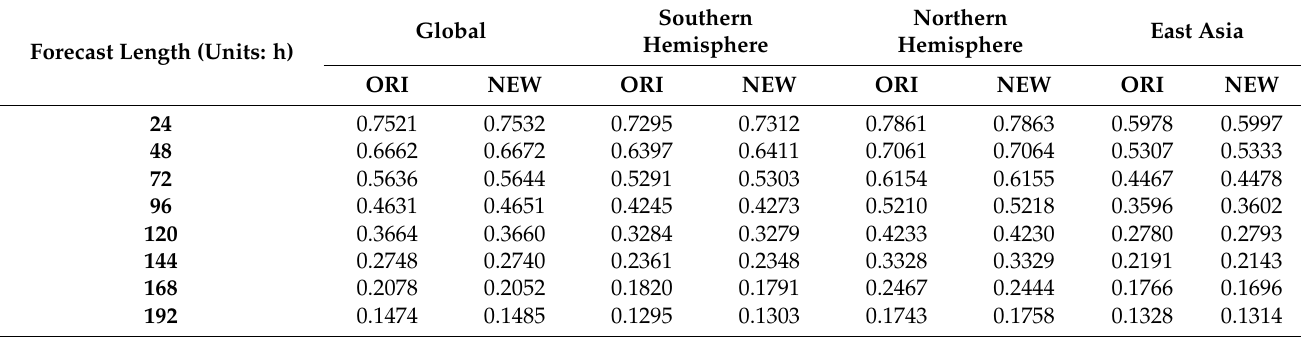
Table 3. ACC of wind speed at 10 m between GRAPES forecast and ERA5 over different regions.